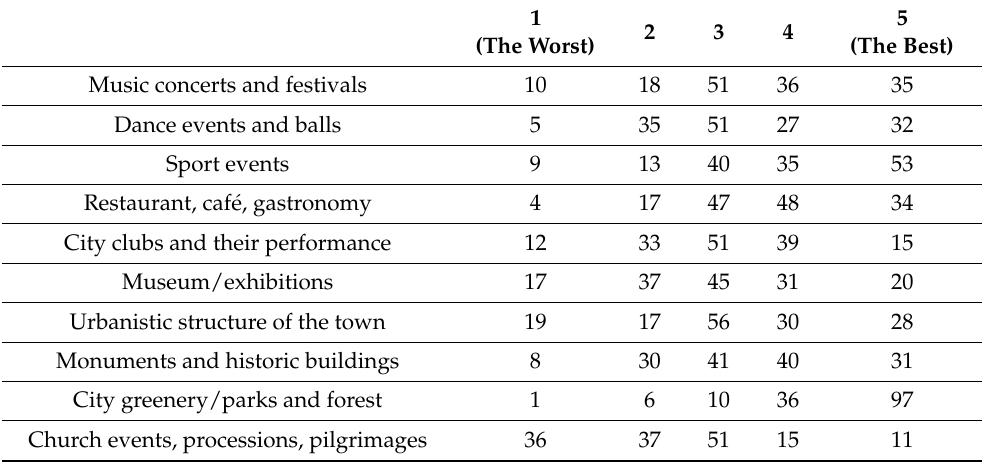
Table 2. Performance of evaluation of different types of attraction in the municipality Choceˇn, Pardubick ý